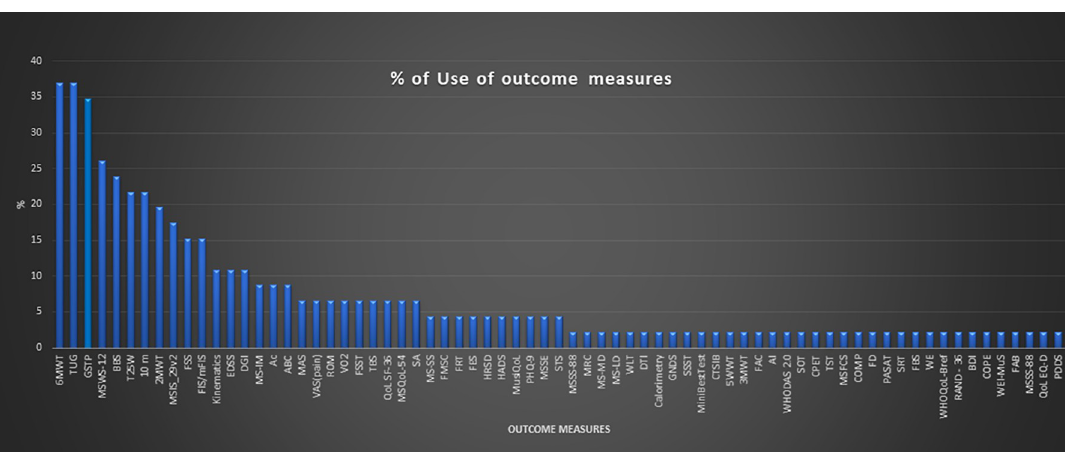
Fig 2. Graph showing the percentage of use of each outcome measure. Abbreviations: 6MWT 6-minute walking test; TUG Timed up and go test; GSTP Gait spatio-temporal parameters; MSWS-12 Multiple sclerosis walking scale-12; BBS Berg balance scale; T25W Timed 25-foot walk; 10m 10-meter walking test; 2MWT 2-minute walking test; MSIS-29 Multiple sclerosis Impact Scale_29; FSS Fatigue severity scale; FIS/mFIS Fatigue impact scale/modified fatigue impact scale; EDSS Expanded disability status scale; DGI Dynamic gait index; MS-IM Muscle strength isokinetik measure; Ac Accelerometers; ABC Activities-specific balance confidence scale; MAS Modified Ashworth scale; VAS (pain) Visual analogic scale (pain); ROM Range of motion; VO2 peak oxygen uptake; FSST Four step square test; TBS Tinetti balance scale; QoL SF-36 Quality of life short form 36; MSQoL-54 Multiple sclerosis quality of life; SA Stabilometric assessment; MS-SS: Muscle strength static strength; FMSC Fatigue scale for motor and cognitive function; FRT Functional reach test; FES Falls efficacy scale; HRSD Hamilton rating scale for depression; HADS Anxiety and depression scale; MusiQoL Multiple Sclerosis International Quality of Life scale; PQH-9 Patient health questionnaire; MSSE Mini mental state examination; STS Sit to stand test; MSSS-88 Multiple sclerosis Spasticity Scale– 88; MRC Medical research council; MS-MD Muscle strength mechanical device; MS-LD Muscle strength lokomat device; WLT Working load in treadmill; DTI Diffusion tensor imaging; GNDS Guy’s Neurological Disability Scale; SSST Six spot step tests; mBEest Test Mini best test; CTSIB Test for sensory interaction and balance; 5MWT 5-minute walking tests; 3MWT 3-minute walking test; FAC Functional ambulatory scale; AI Ambulatory index; WHODAS 2.0 World health organization disability assessment schedule; SOT Sensory organization test; CPET Maximal cardiopulmonary exercise test; TST Timed stair test; MSFCS Multiple sclerosis functional composite; COPM Canadian occupational performance measure; FD Falls diary; PASAT Paced auditory serial attention test; SRT sit and reach test; FBS Fullerton balance scale; WE Wurzburger inventory; WHOQoL-Bref WHO quality of life-bref; RAND-36 Random 36 health survey; BDI Beck depression inventory; COPE Coping Orientation to Problem Experienced; WEI-MuS Wurzburg Fatigue Inventory for Multiple Sclerosis; FAB Frontal assessment battery; MSSS-88 Multiple sclerosis Spasticity Scale; QoL-EQD Euro quality of life; PDDS Patient Determined Disease